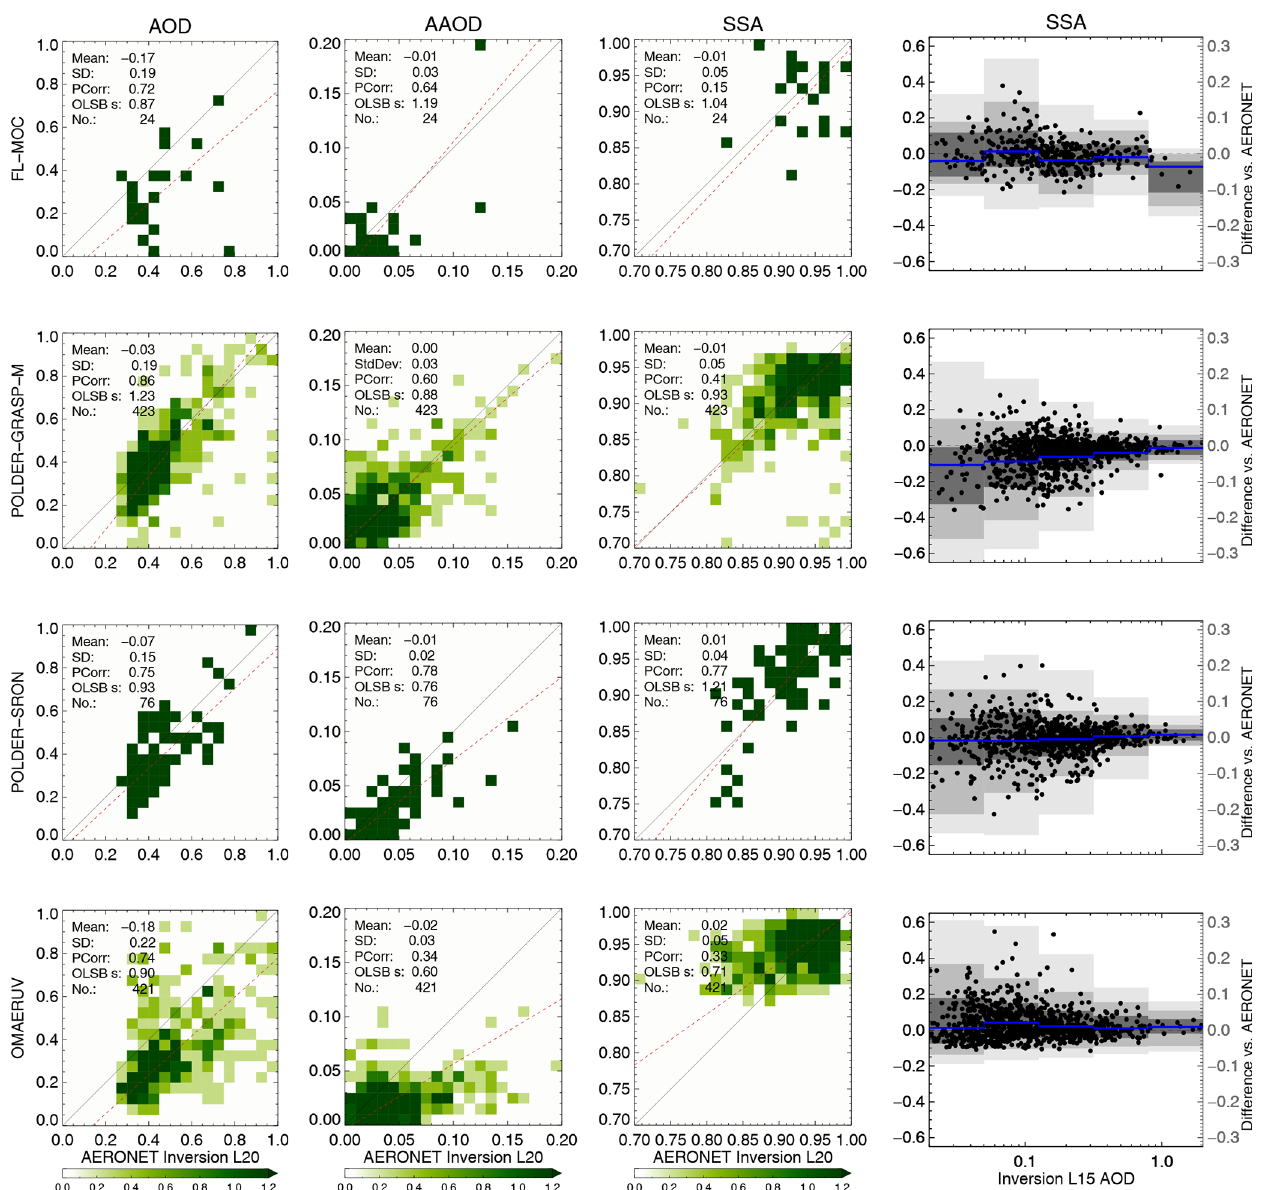
Figure 9. Evaluation of super-observations of AOD, AAOD and SSA for the satellite products. SSA is also evaluated as a function of AOD (binned). In the three leftmost figures, the colour indicates amount of data in percentages; for an explanation of the metrics, see Sect. 3.3. The rightmost column uses two vertical axes: the left y axis is used for individual data points (subsampled), and the right y axis is used for the greyscale distribution (9%, 25%, 50%, 75% and 91% quantiles of the differences) and the median difference (blue line). Products were individually collocated with AERONET Inversion L2.0 within 3h, except for the rightmost column, which used Inversion